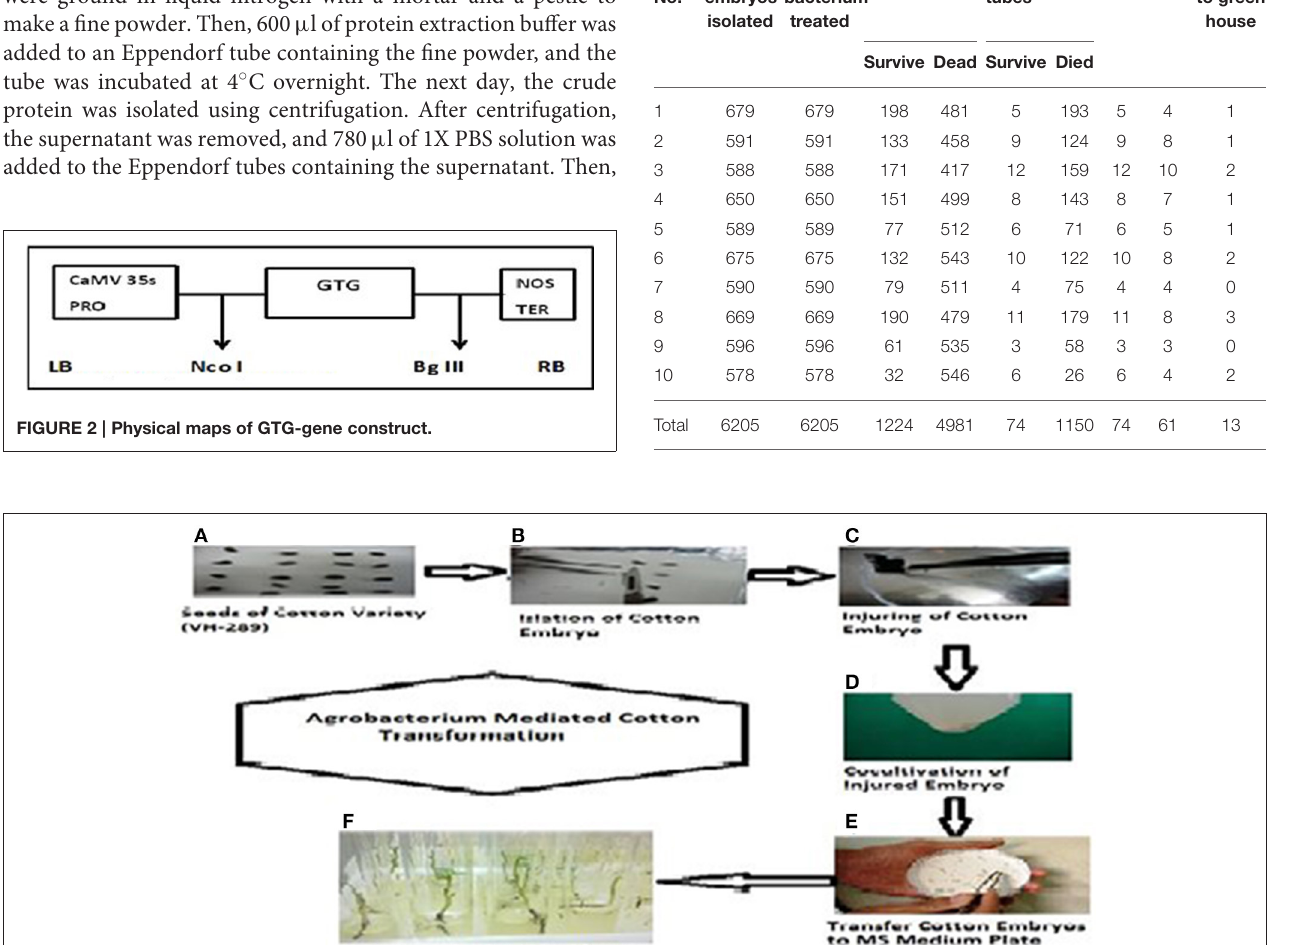
TABLE 2 | Germination and tissue culture of cotton embryos for transformation. Sr. No.